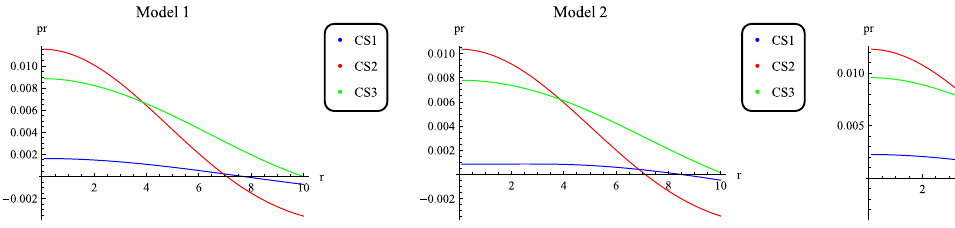
Fig. 2 Radial pressure evolution of the strange stars